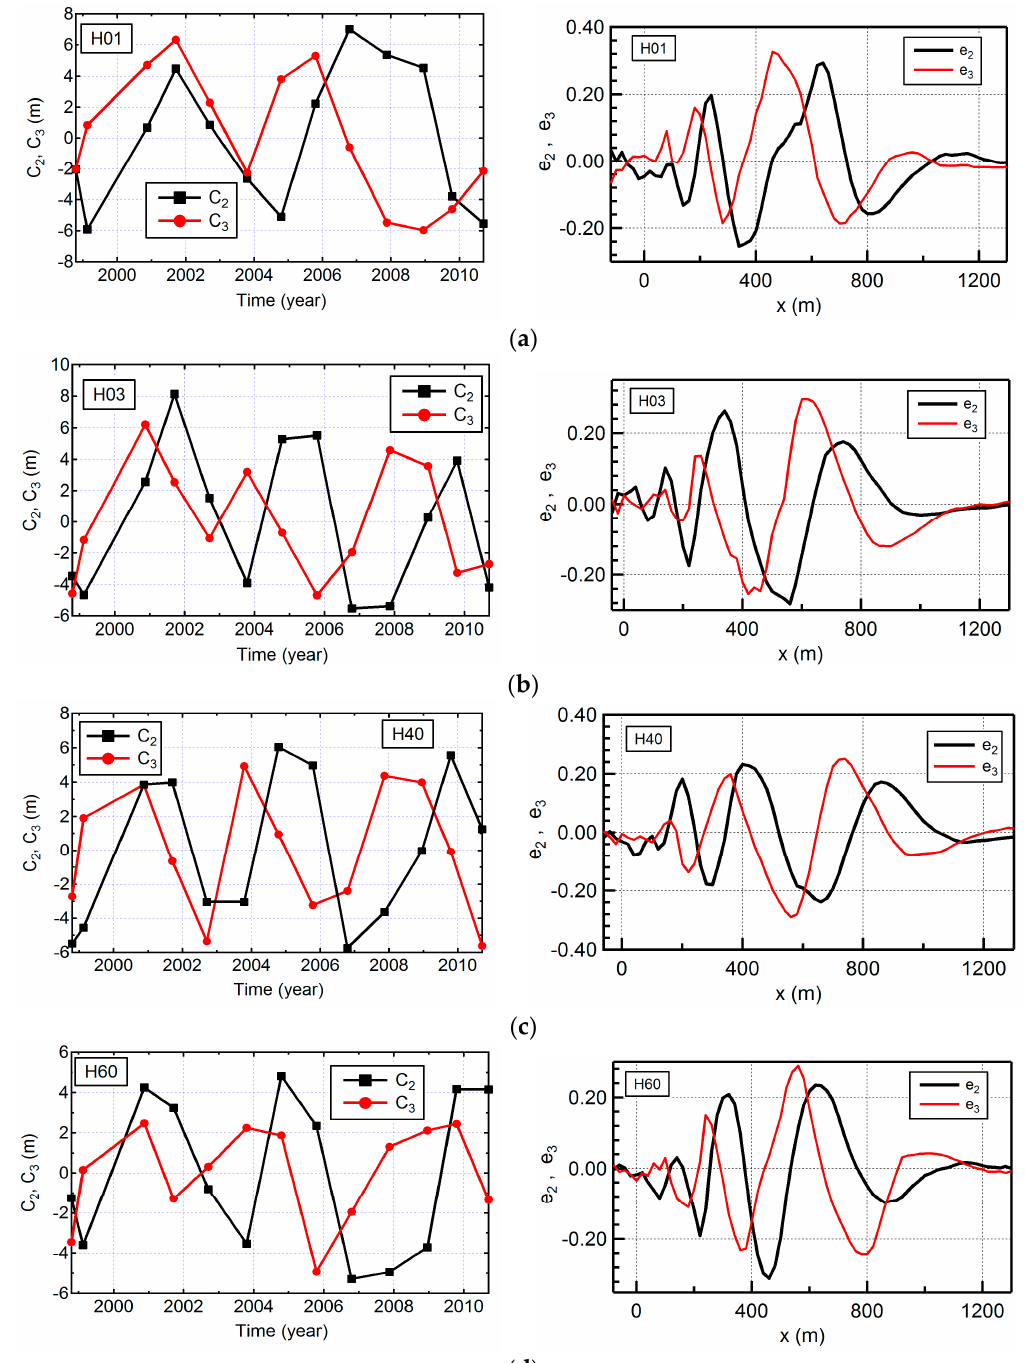
Figure 17. Temporal and spatial eigenfunctions of the second and third modes.